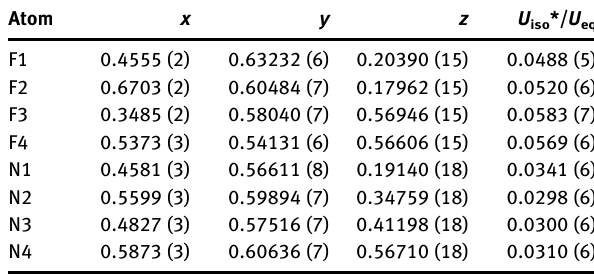
Table  : Fractional atomic coordinates and isotropic or equivalent isotropic displacement parameters (Å 